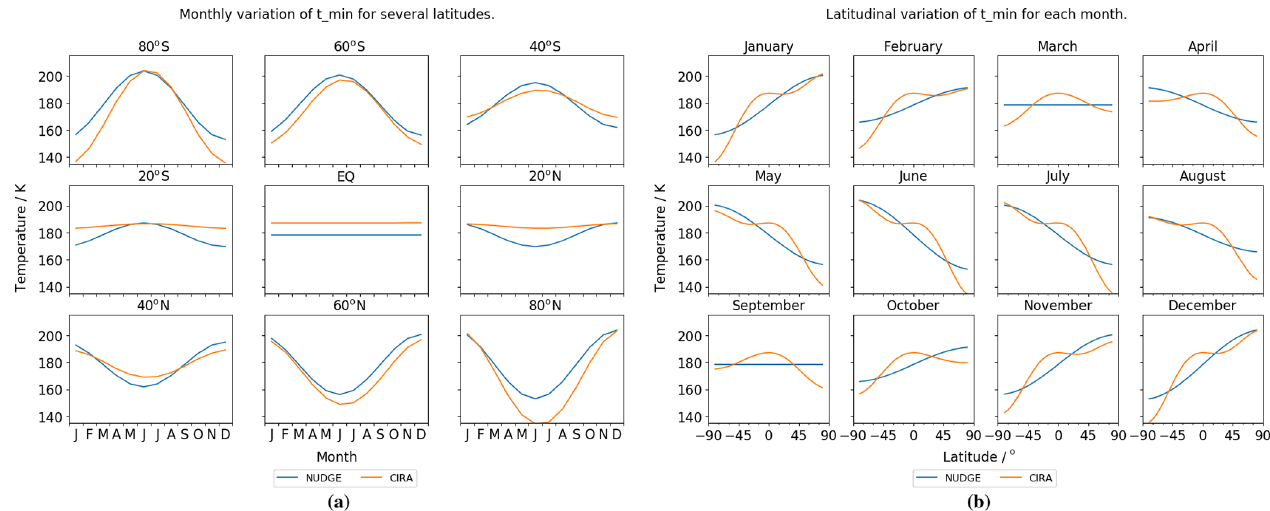
Figure 1. Variation in the fitted mesopause temperature profile T min for (a) several latitudes as a function of month and (b) all months as a function of latitude. The fitted function gives a reasonable fit for the purposes of the nudging scheme.